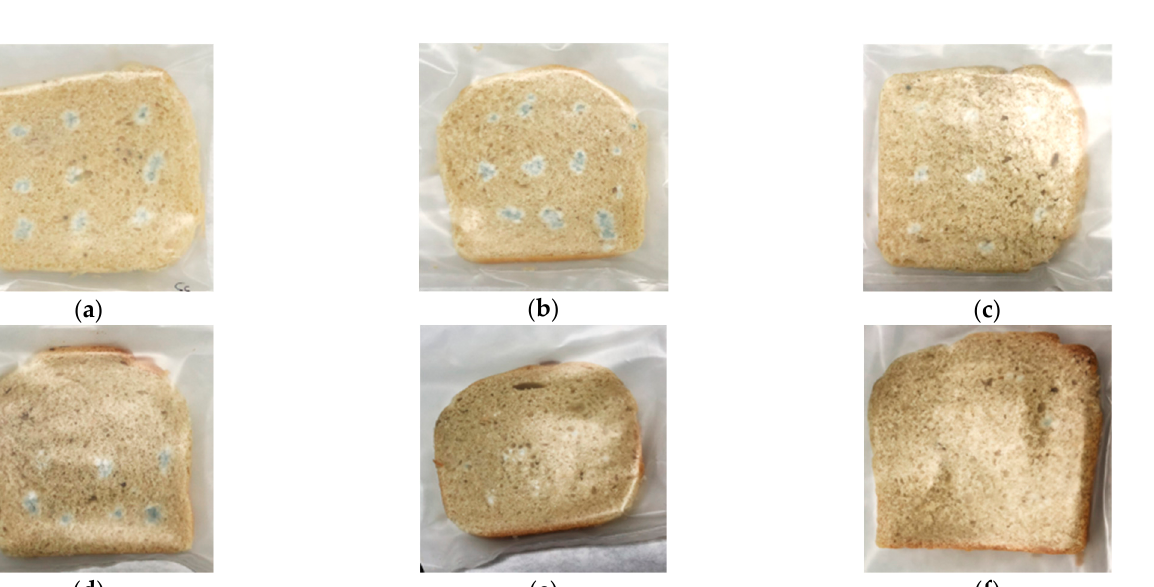
Results are expressed as follows: ( − ) means no superficial growth detected; (+) means superficial mycelium detected; (++) means superficial mycelium with spores detected.